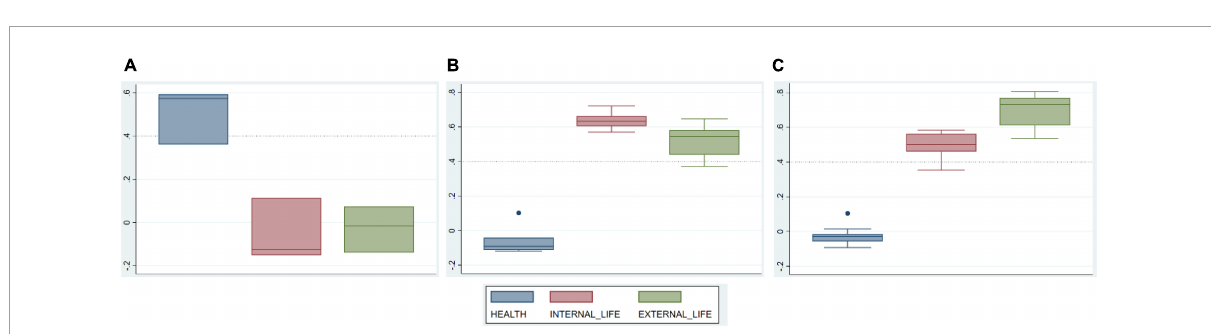
measuring the QOL of young adults in Vietnam.